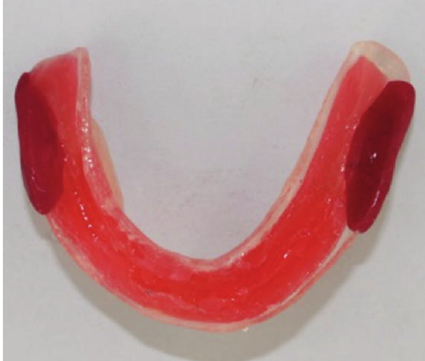
Figure 12: Completed mandibular impression with monophase polyvinylsiloxane material.